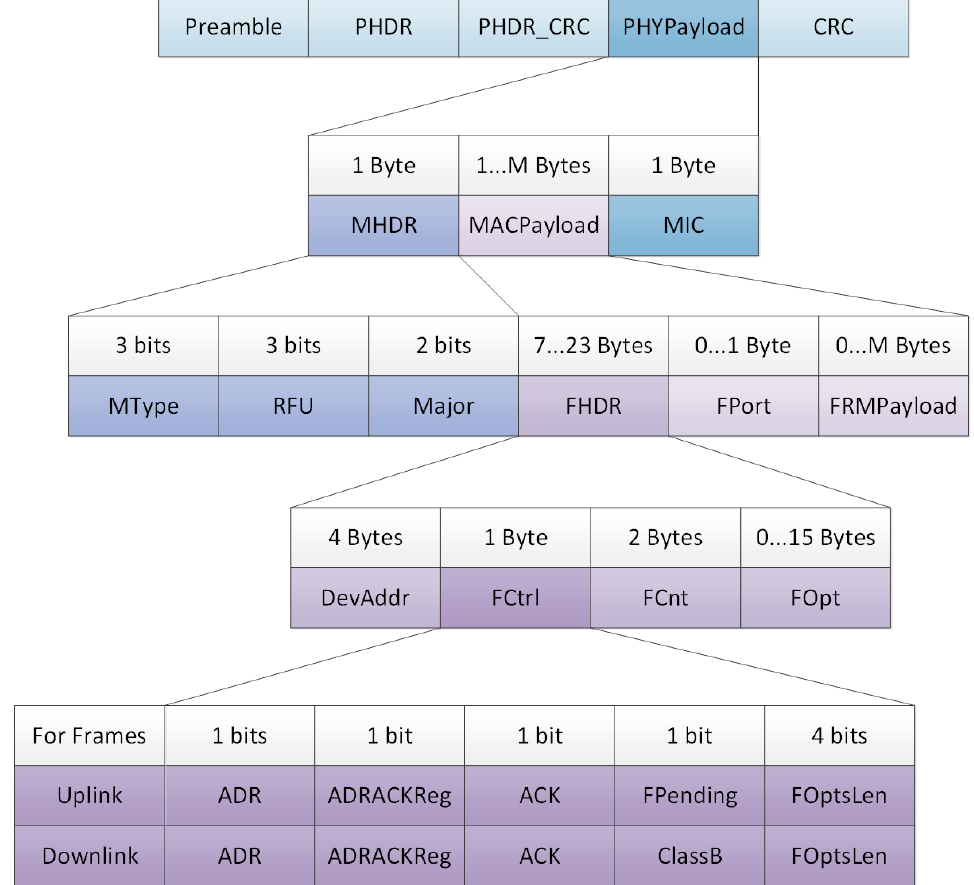
Figure 7 shown the standard LoRaWAN Radio PHY layer message structure in order to establish a comparison line with the protocol proposed in this paper.